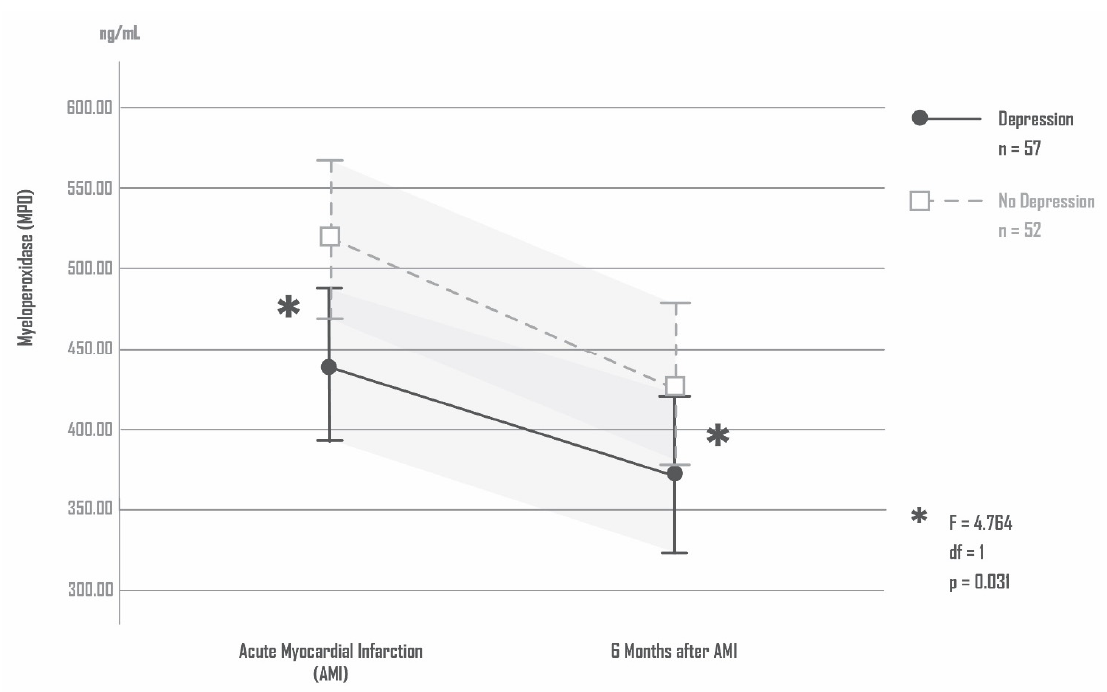
Figure 3. Levels of MPO in patients with and without AMI-induced depression.